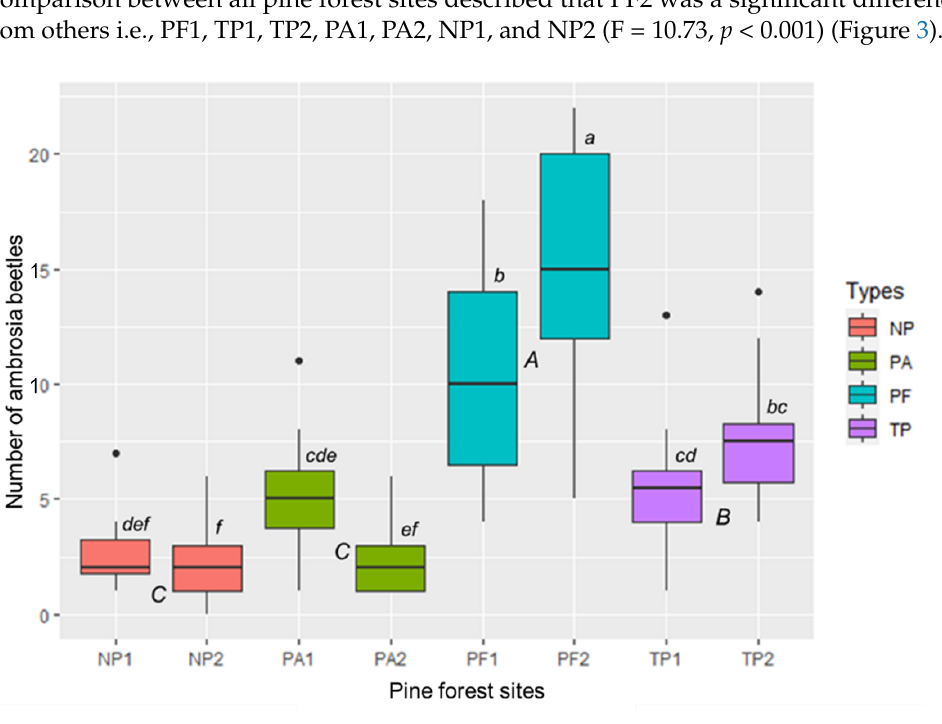
Figure 4. The heatmap of the Jaccard distance is based on the number of ambrosia beetle abundance and species between each pine forest site.